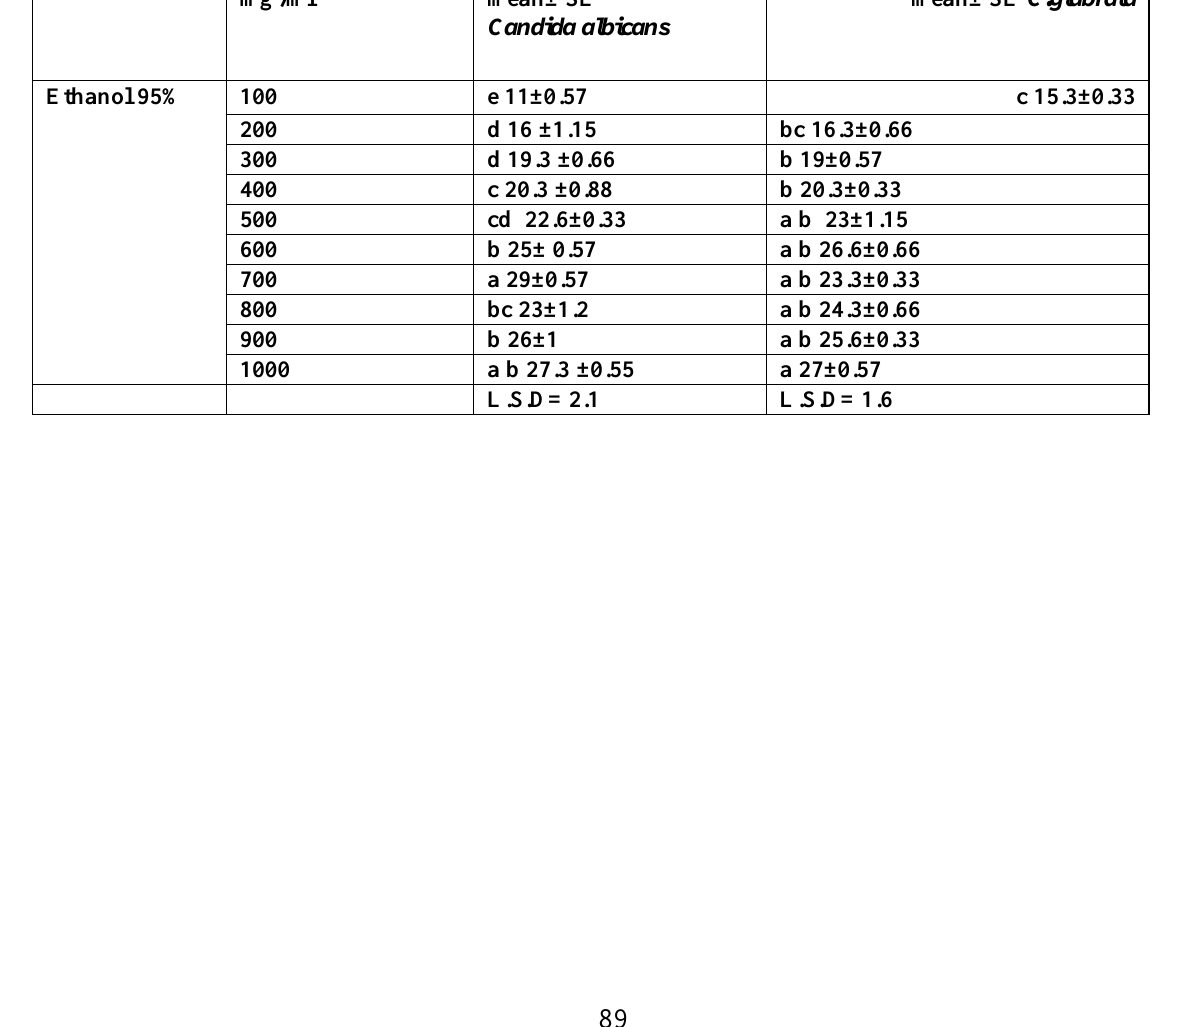
Table 2: .The effects of Alcoholic (ethanol ) of Quercus infectoria extract on Candida albicans and C.glabrata in vitro Type of